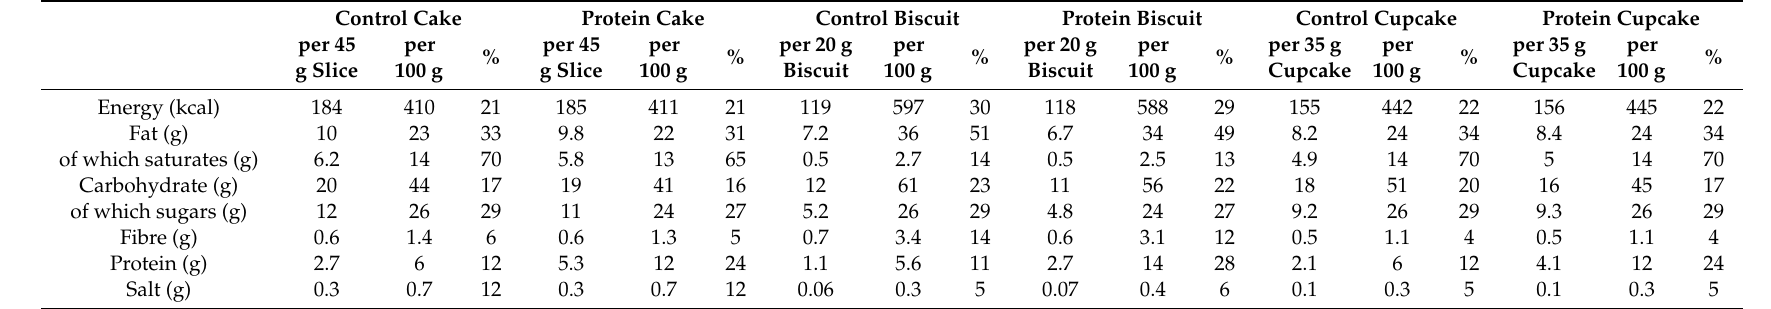
Table 1. Nutritional composition per portion size and 100 g with % of reference intake for cakes, biscuits and